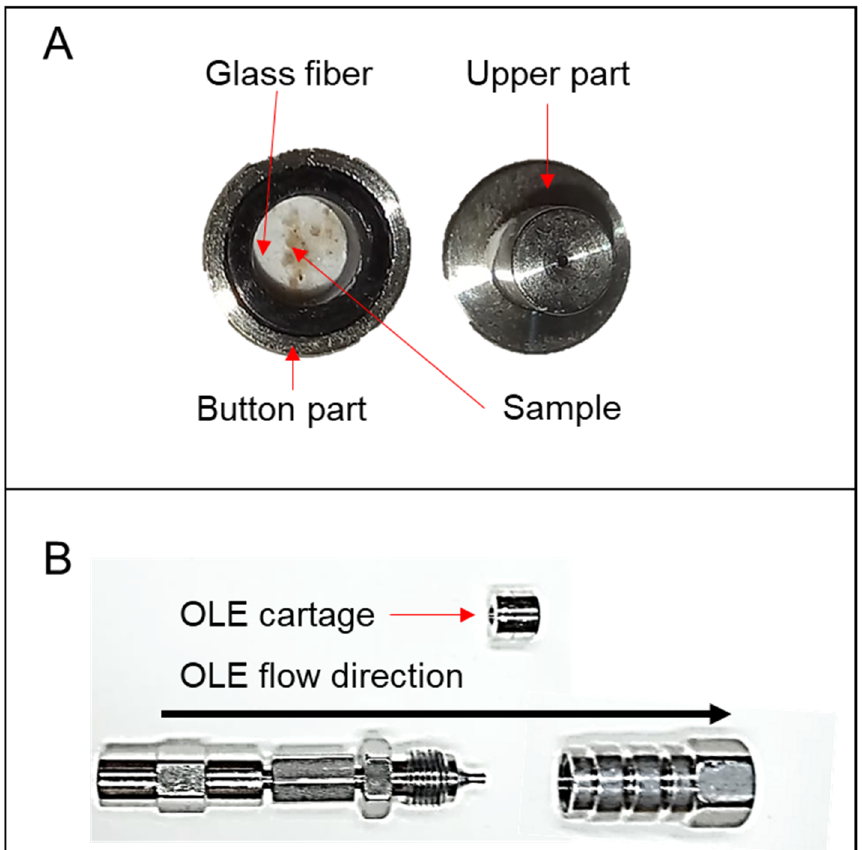
Figure 1. Set up of the analytical OLE system. ( A ) Example of OLE cartridge and the sample deposited on it. ( B ) Example of OLE hardware and flow direction during